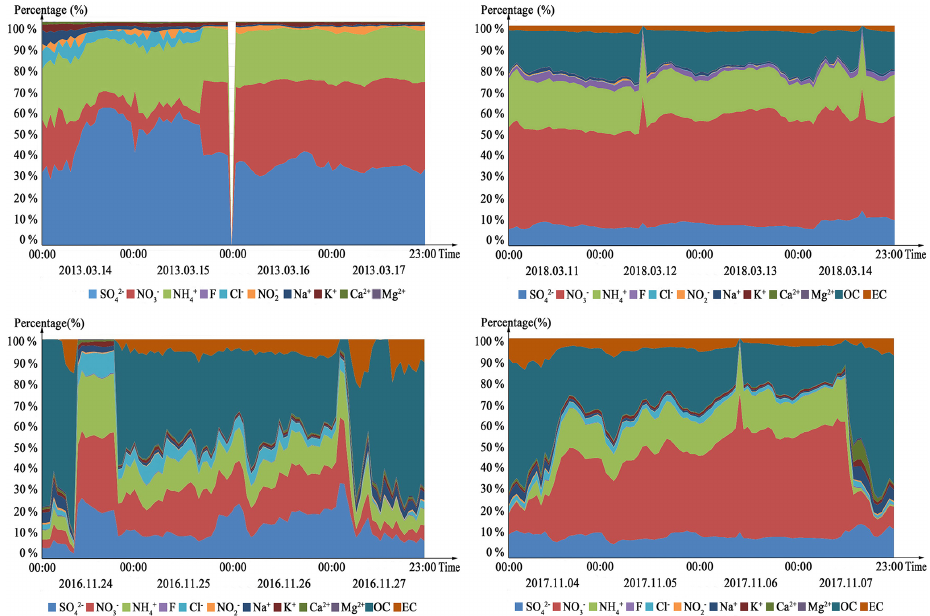
Figure 3. The variation in PM 2 . 5 components in Beijing during four pollution episodes. The blank area for the pollution episode in March 2013 resulted from missing data caused by equipment error. Organic carbon and elemental carbon component were not measured during the pollution episode in March